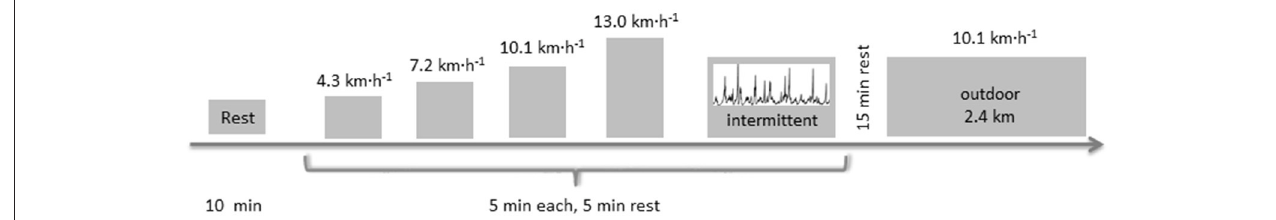
FIGURE 1 | Exercise study